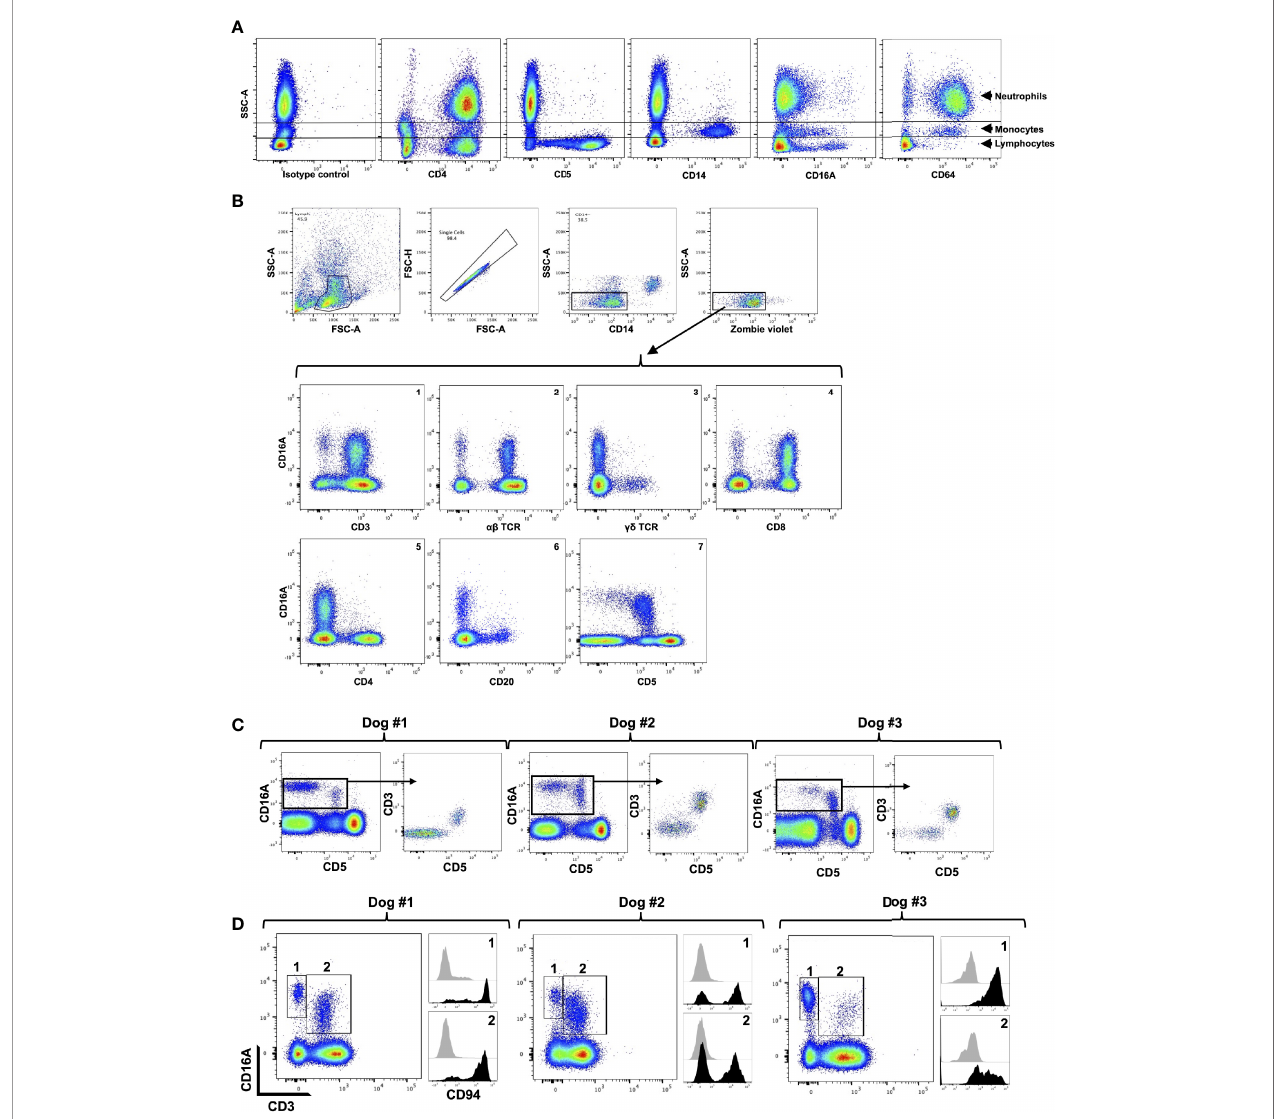
FIGURE 2 | CD16A and CD64 expression by canine leukocyte subsets. (A) Canine peripheral blood leukocytes were stained for the indicated markers and examined by fl ow cytometry. The y-axis = light side scatter area (SSC-A) and the x-axis = Log 10 fl uorescence. Data are representative of multiple independent experiments using leukocytes from separate canine donors. (B) CD16A is expressed by T cells and non-B cell, non-T cell lymphocytes. The top panels show the gating strategy on peripheral blood mononuclear cells to examine single cell, viable, lymphocytes. The gating strategy was used in B-C. The bottom panels show the expression of CD16A on various lymphocyte populations using the indicated markers. All data are representative of multiple independent experiments using leukocytes from separate canine donors. (C) CD16A expression on CD5 − and CD5 + lymphocytes. For each dog examined, CD16A versus CD5 staining of lymphocytes was determined (left panel). From this plot, CD16 + cells were gated and their expression of CD3 versus CD5 determined. (D) Expression of CD94 by CD3 − CD16 + and CD3 + CD16 + lymphocytes. These populations were gated on for each dog examined (left panel) and their staining levels of CD94 were determined (right panel), as indicated by the corresponding numbers. The black fi lled histograms represent CD94 staining, and the grey fi lled histograms represent isotype- matched negative control staining. For panels (C, D) different dogs were